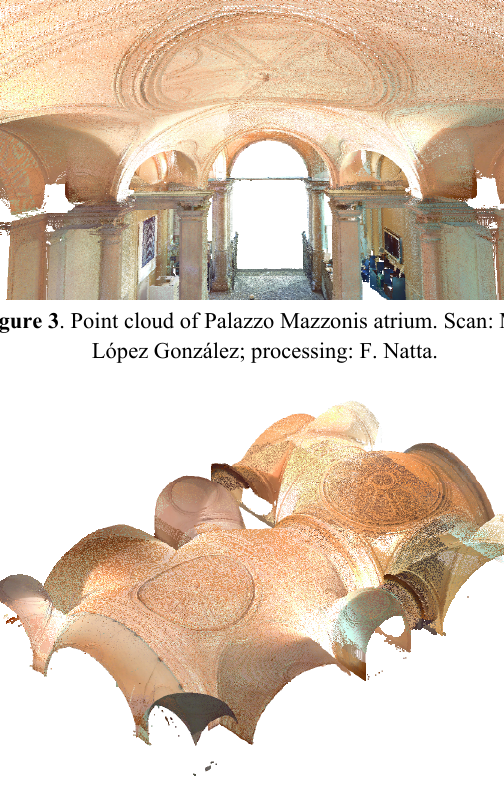
Figure 4 . Segmentation of the point cloud of Palazzo Mazzonis atrium: vaulted surface. Scan: M. C. López González; processing: F.